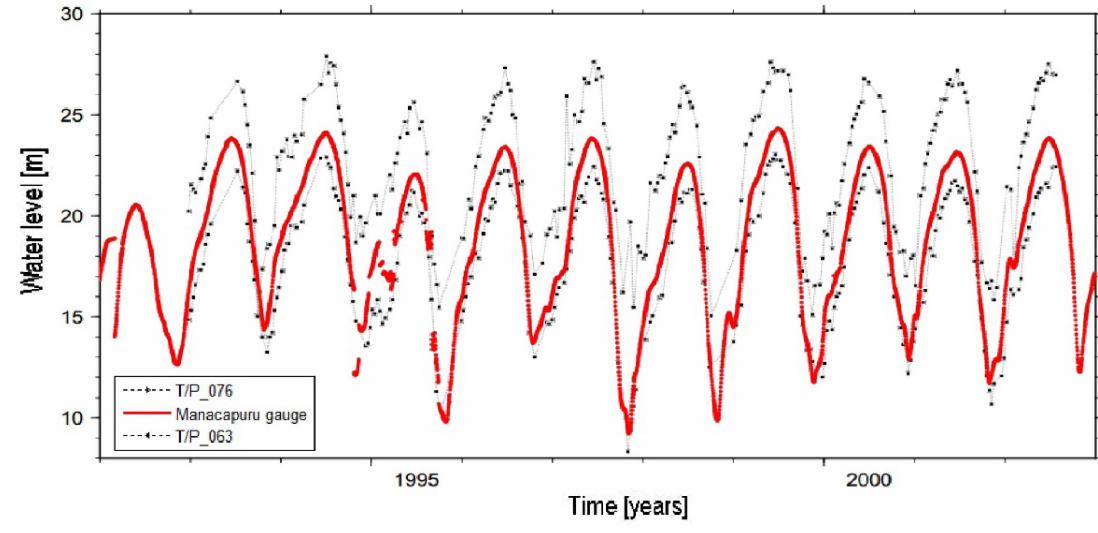
Figure 2. Temporal series of Manacapuru gauge, T/P_076 SV and T/P_063